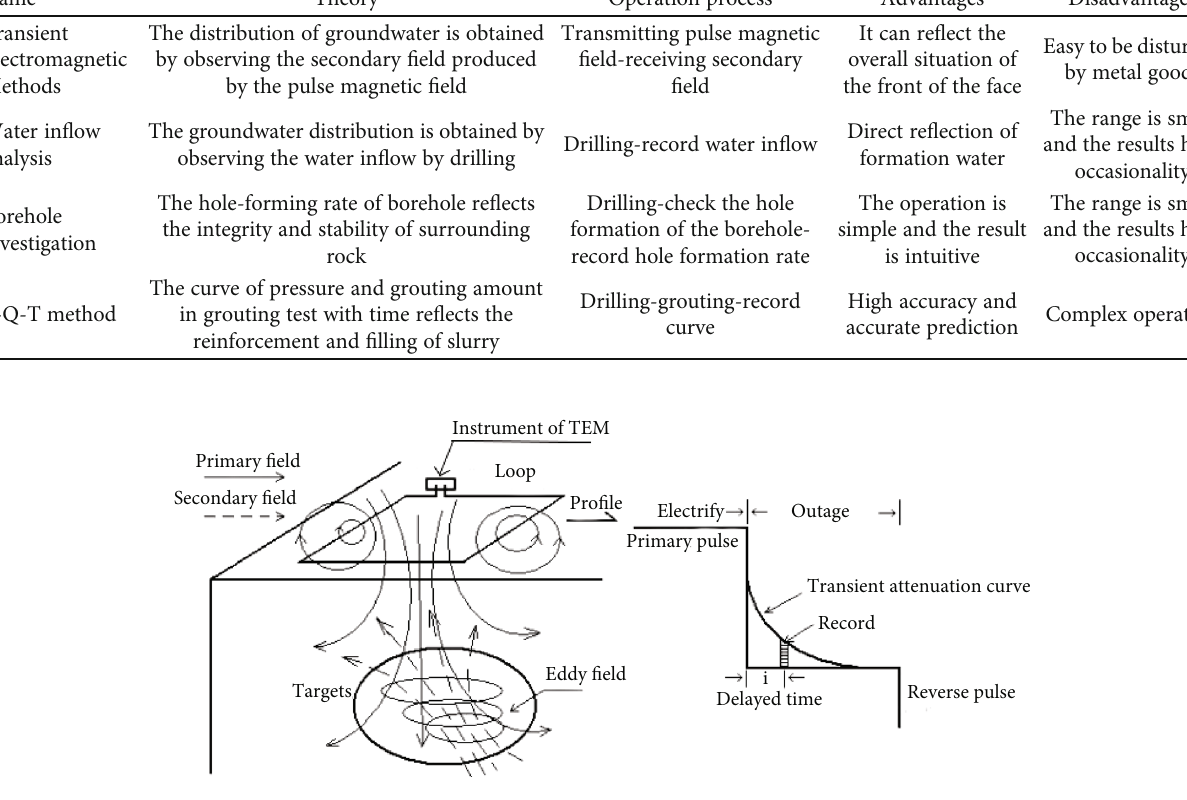
Figure 8: The principle of TEM.